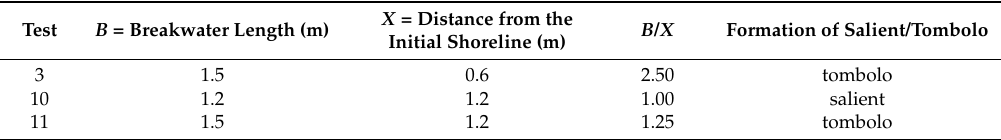
Table 1. Test conditions for the numerically reproduced experiments of Ming and Chiew [21]. X = Distance from the Test B = Breakwater Length (m) Initial Shoreline (m)